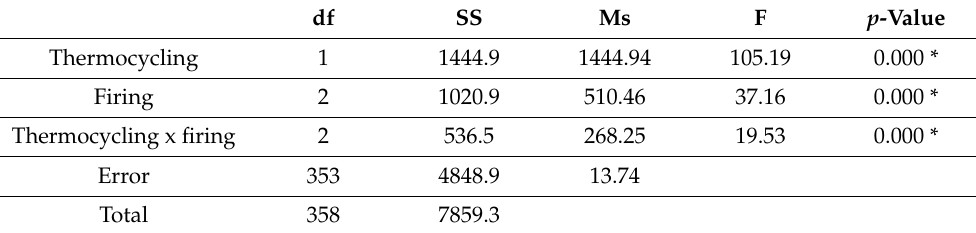
Table 4. Two-way ANOVA for µ SBS data.